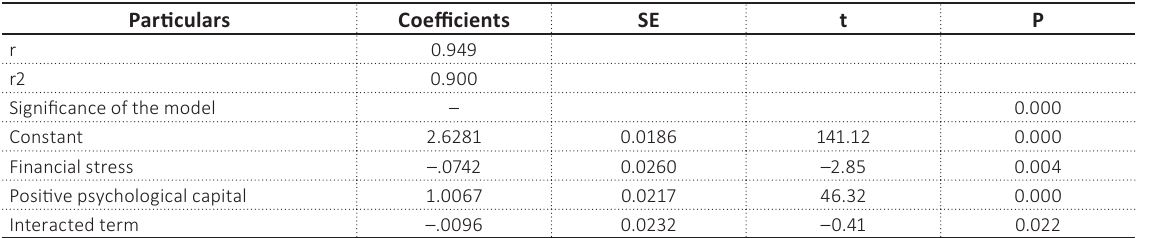
Table 8. Model fit